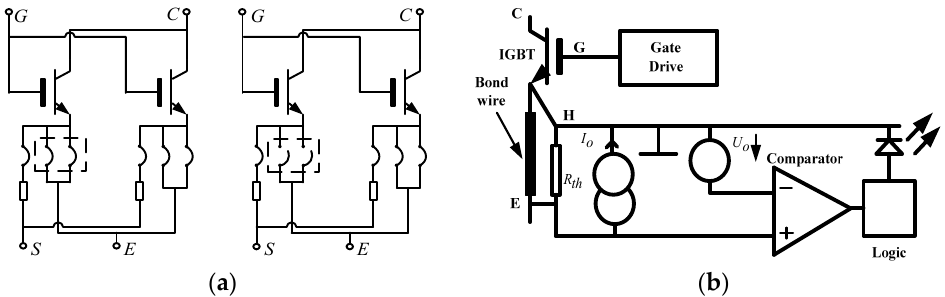
Figure 24. Fault detection based on gate-voltage monitoring [57].